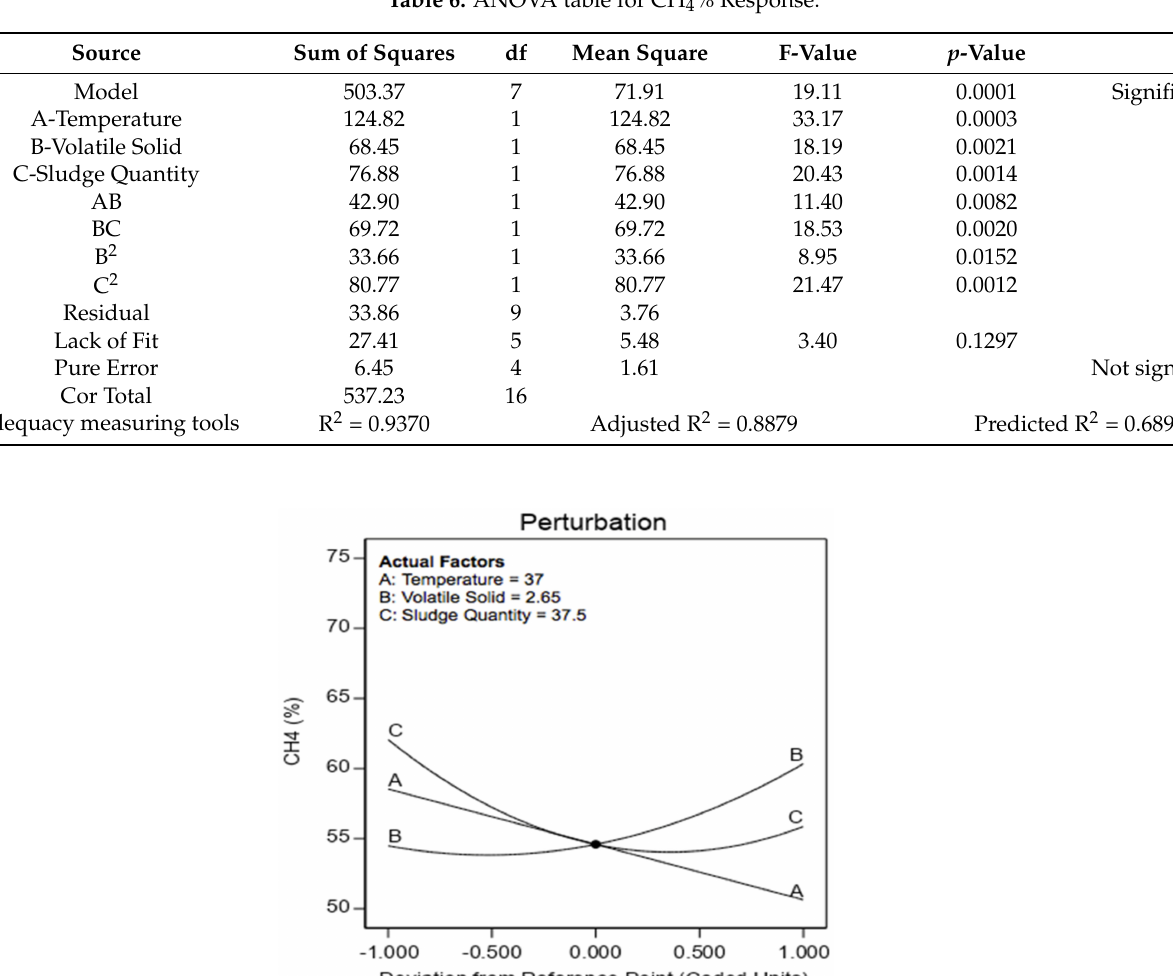
Table 6. ANOVA table for CH 4 % Response.